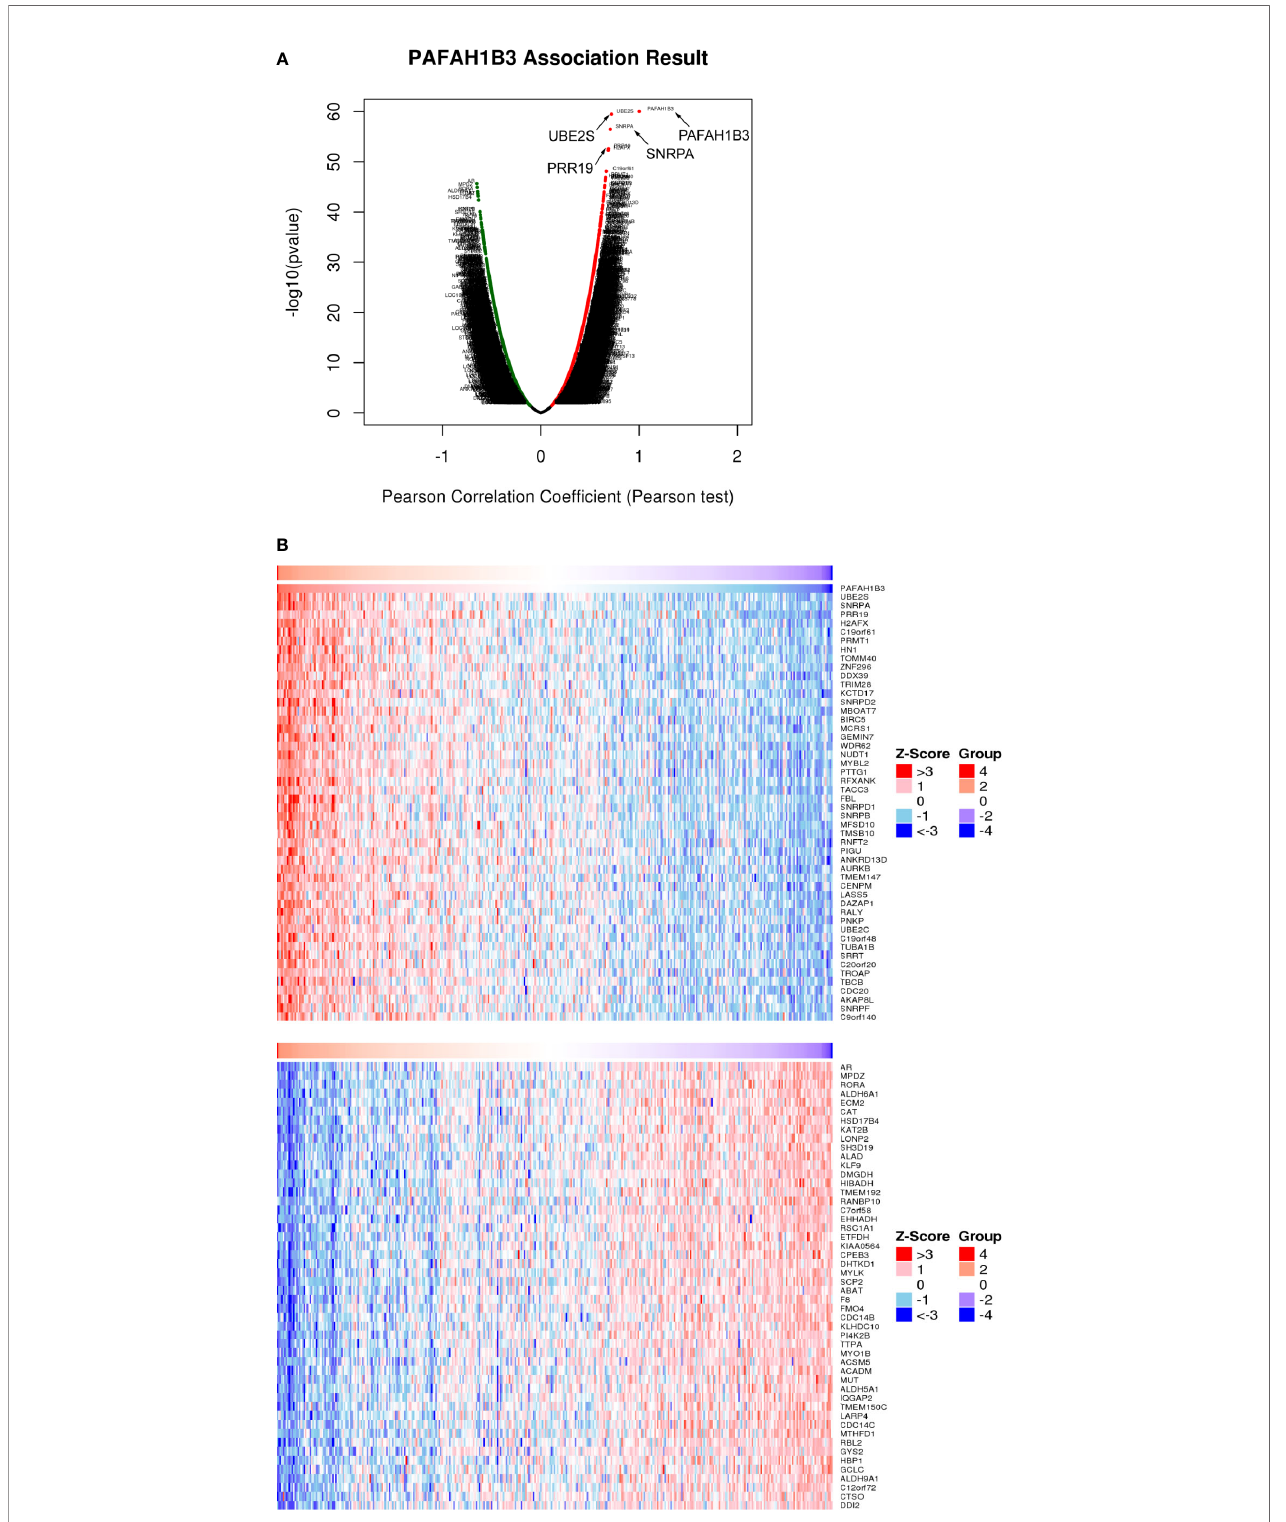
FIGURE 3 | Coexpression of PAFAH1B3 in hepatocellular carcinoma (HCC) (LinkedOmics). (A) Total genes highly correlated with PAFAH1B3. (B) Heatmaps showing the 50 signi fi cant genes positively and negatively correlated with PAFAH1B3 in LIHC. Red and blue indicate positively and negatively correlated genes,